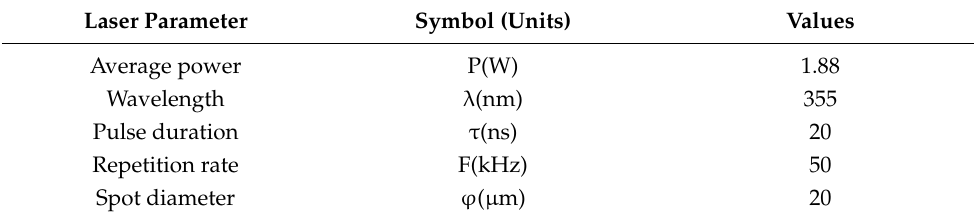
Figure 2. Schematics of the UV laser and of micro-pit array processing. ( a ) UV laser processing equipment, ( b ) Circular micro-pit processing, ( c ) Circular pit distribution. Table 1. Process parameters for laser-based fabrication of hydrogel surface